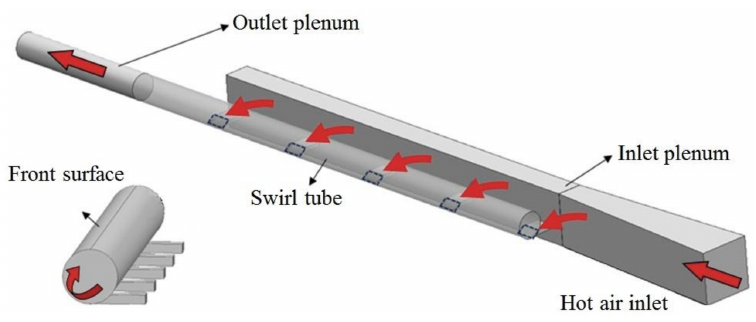
Figure 2. Computational model of swirling hot air anti-icing